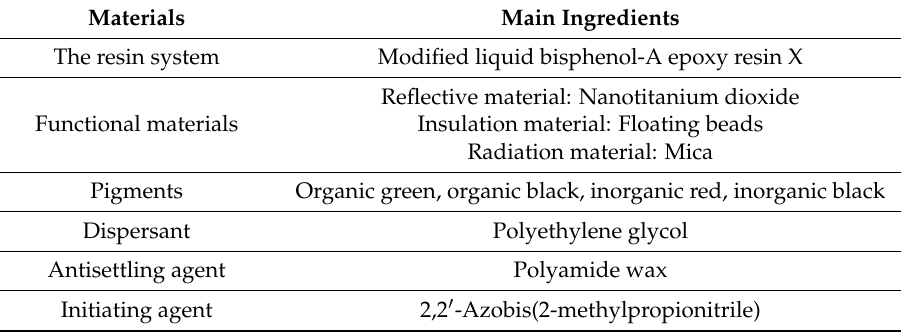
Table 1. The main raw materials of the paintings.